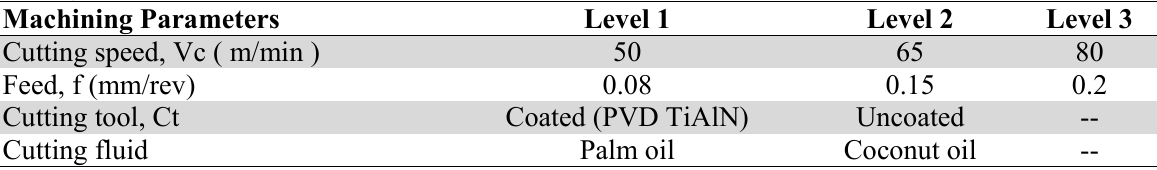
Turning Parameters and their levels